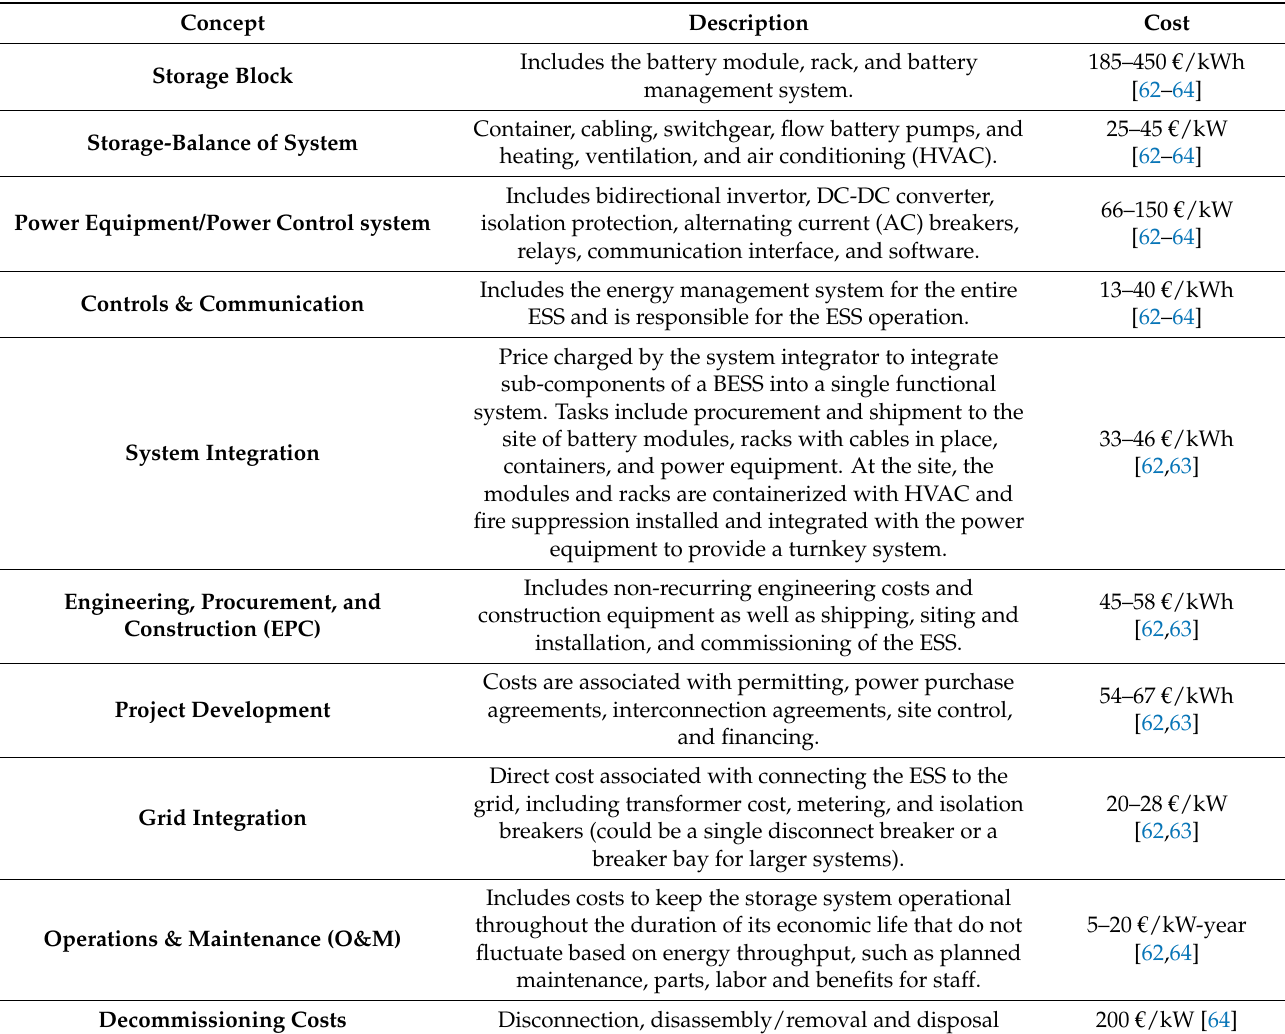
Table 3. Cost associated with the installation of a